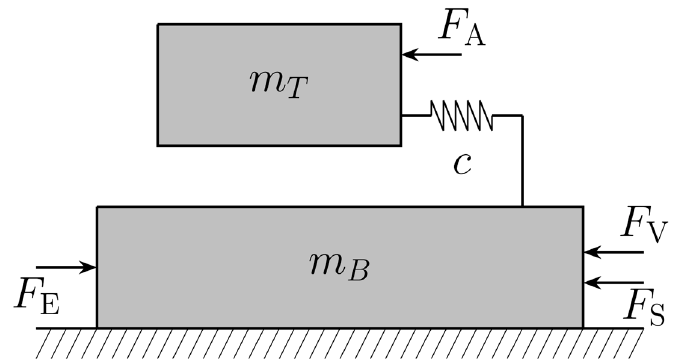
Figure 15. Mechanical analogy for droplet modelling.